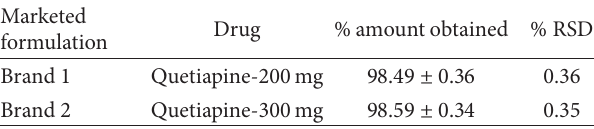
T 10: Results of quetiapine fumarate in marketed product.